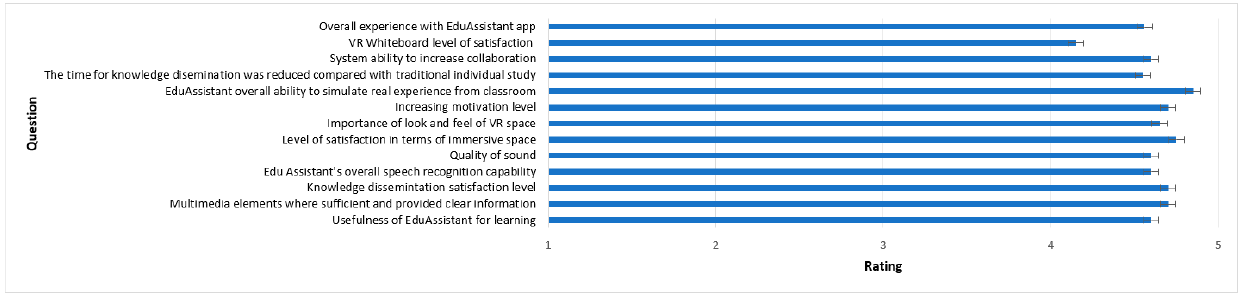
Figure 23. Level of satisfaction after using the EduAssistant platform.